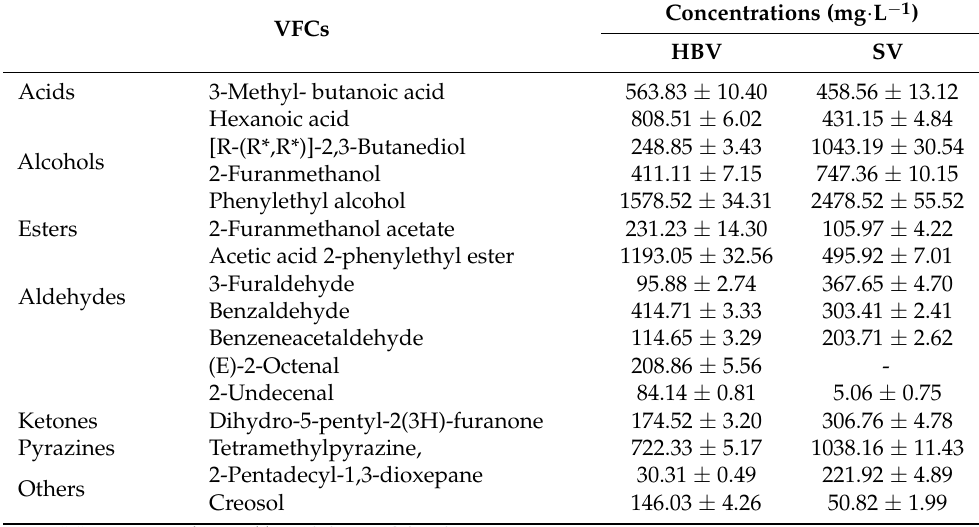
Table 5. Summary of main VFCs in aged HBV and